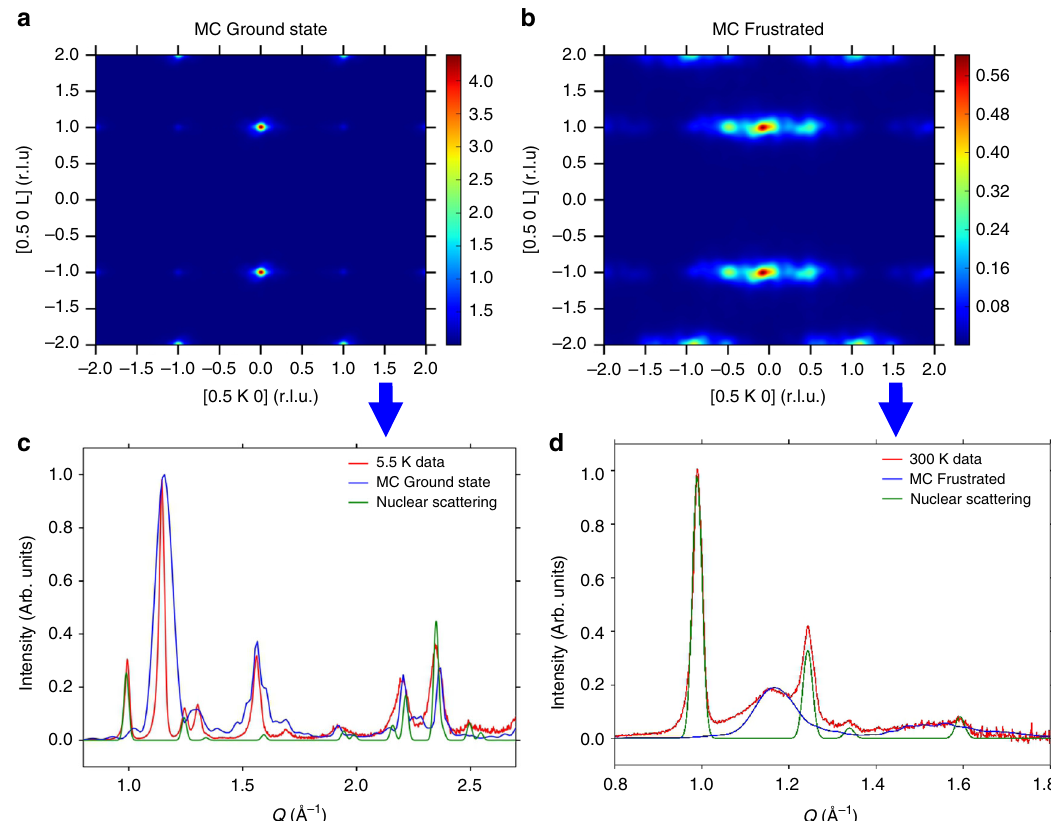
Fig. 6 Magnetic scattering calculated from the MC simulation for charge ordered CaFe 3 O 5 . The upper panels show the 0.5 KL scattering plane calculated from the MC simulations with (i.e. “ MC Ground State ” ) ( a ) or without (i.e. “ MC Frustrated ” ) ( b ) the Y 3 − ( σ ) distortion that relieves the frustration of the J 4 and J 5 exchange paths (See also Supplementary Fig. 1). The lower panels show experimental neutron powder diffractograms (red) of sample A alongside the corresponding Monte Carlo computation of the powder average nuclear (green) and magnetic (blue) scattering. The simulation with the Y 3 − ( σ ) distortion ( a ) shows that the commensurate ground state accounts well for the powder average magnetic scattering when included in its computation ( c ). Without the Y 3 − ( σ ) distortion, rods of diffuse scattering form b indicating short range correlations and the absence of long range order due to the frustration of the J 4 and J 5 exchange paths. d shows the good agreement of the diffuse scattering at 300 K with the simulation suggesting the presence of fully formed trimeron units well above T N